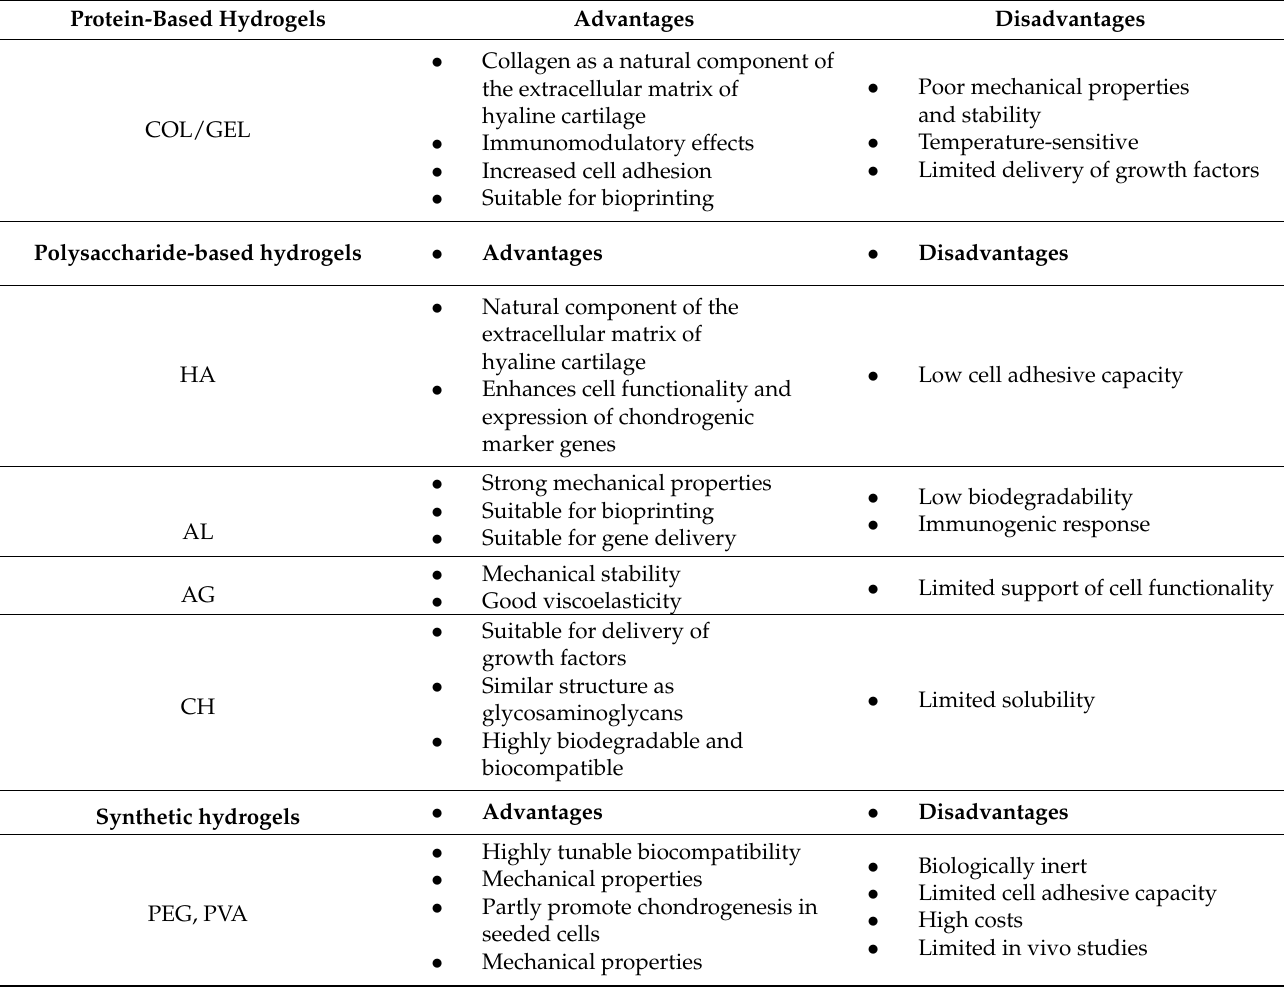
Table 1. Advantages and disadvantages of selected natural and synthetic hydrogels for cartilage engineering. Protein-Based